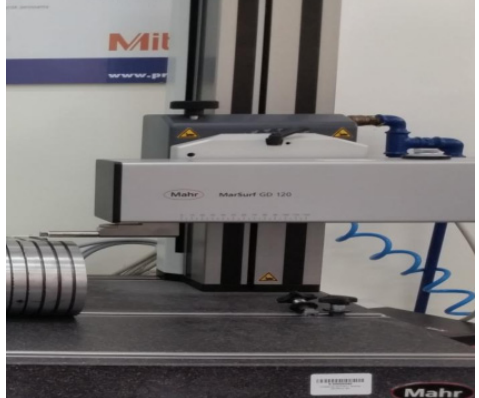
Figure 14. Mahr Gd 120 profilografometer equipped with a magnetically fixed measuring needle (MFW 250B).